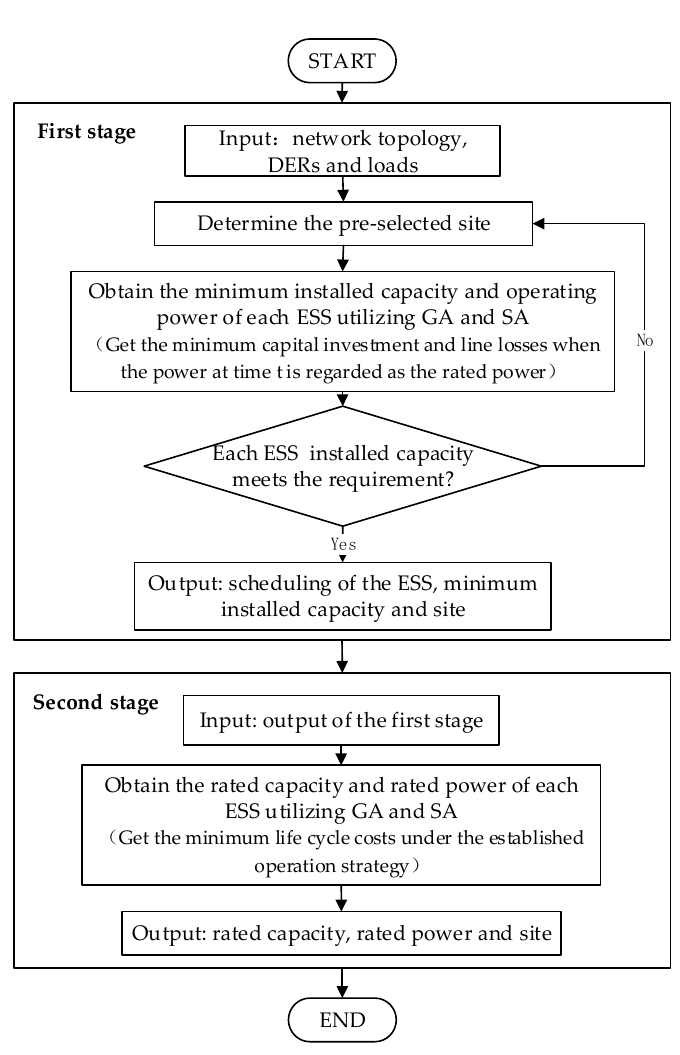
Figure 2. Schematic diagram of the proposed two-stage optimal planning strategy.